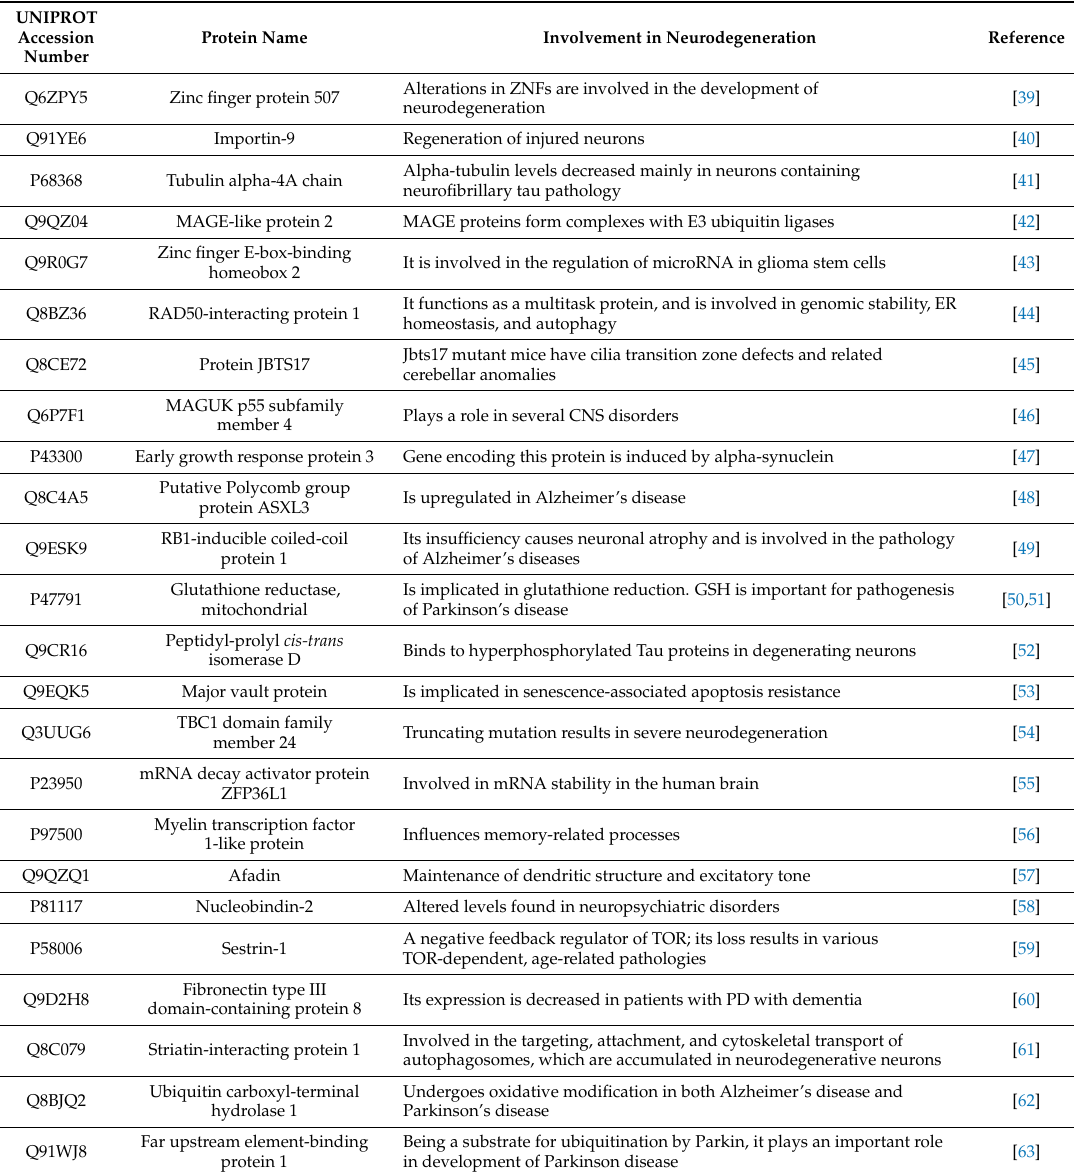
Brain proteins ubiquitinated in mice treated with MPTP and their involvement in